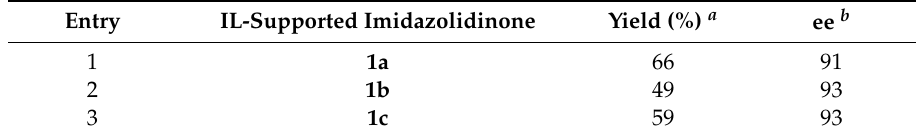
Table 1. Yield and enantiomeric excess (ee) of ( − )- 15 in ionic liquid ( 1a ‒ c )-supported reactions. a.